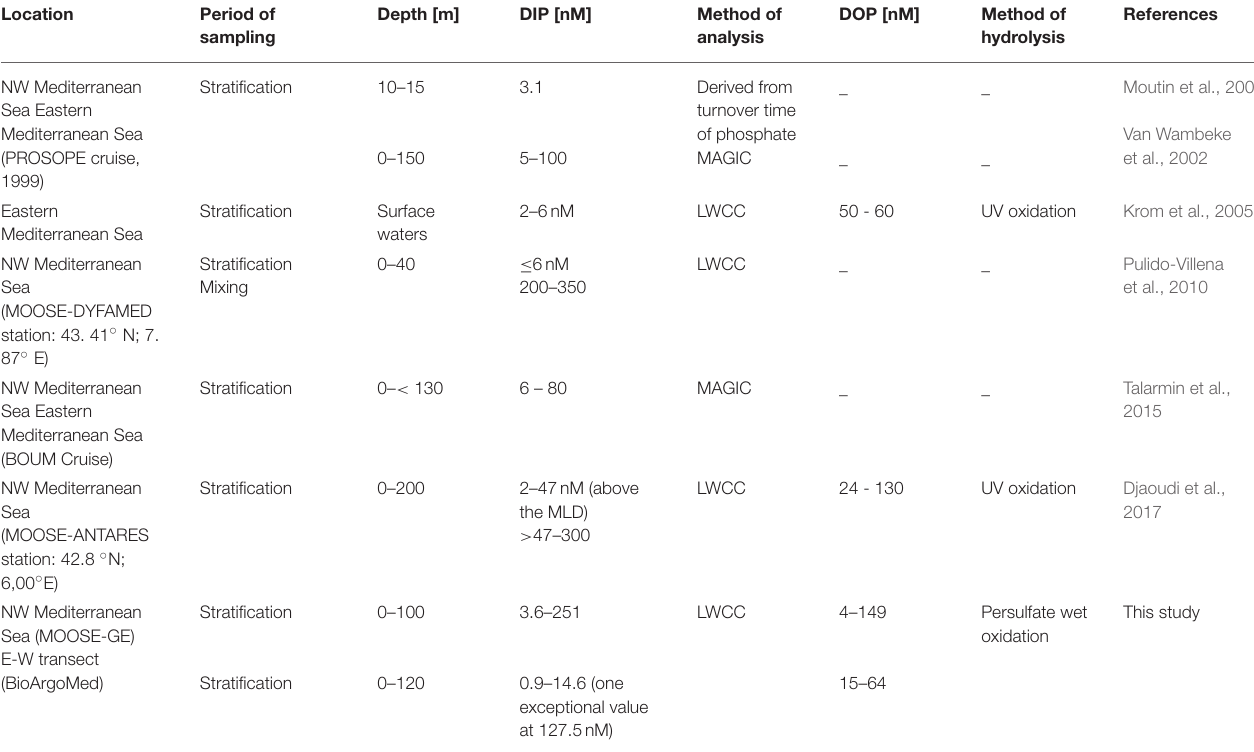
TABLE 1 | Summary of published data on nanomolar dissolved inorganic phosphate (DIP) and dissolved organic phosphate (DOP) concentration in the Mediterranean Sea.